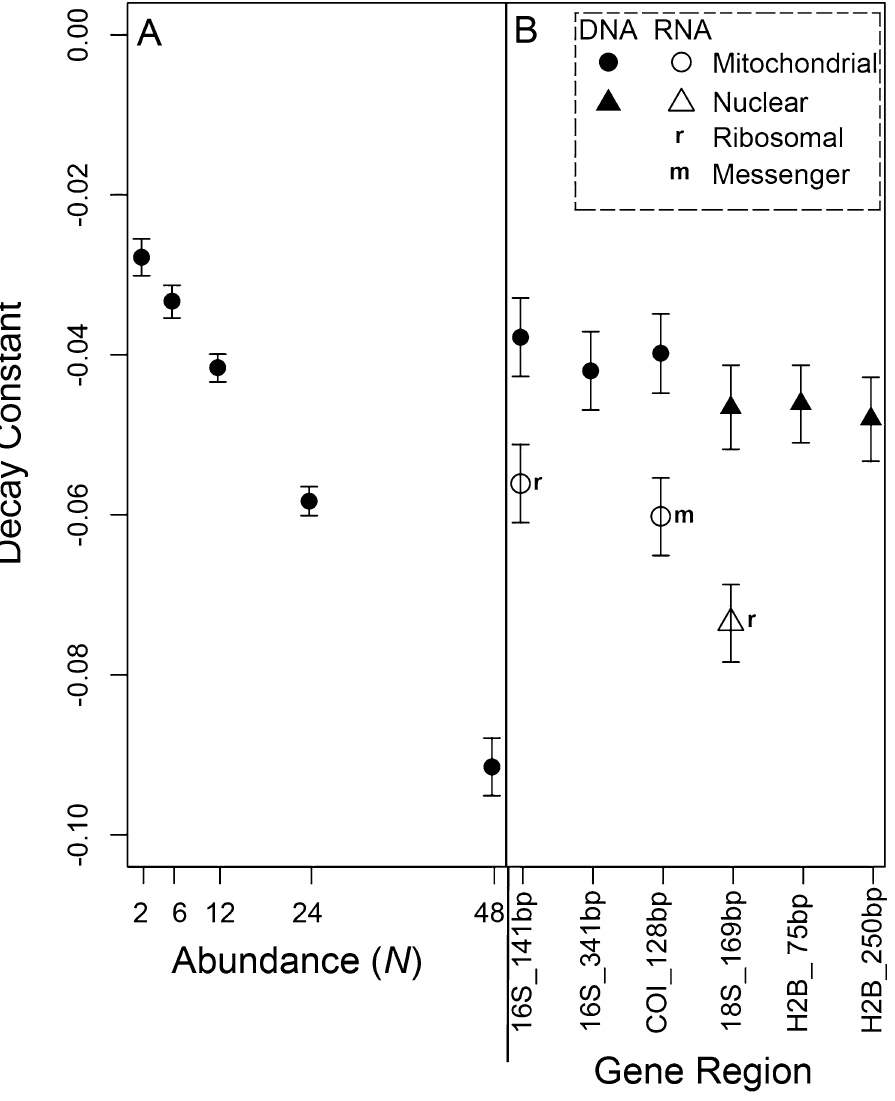
Figure 3. Decay constant calculated from a first-order exponential decay model across times 0 to 72 h for ( A ) mussel abundance with all genetic markers combined, and ( B ) across each of the target gene markers with all abundances combined. Interactions between gene marker and abundance are in the Supplementary Information, including Supplementary Fig. S3. Error bars represent 95% confidence